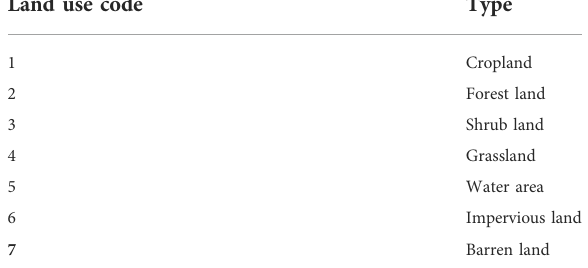
TABLE 1 Code table of land use types. Land use